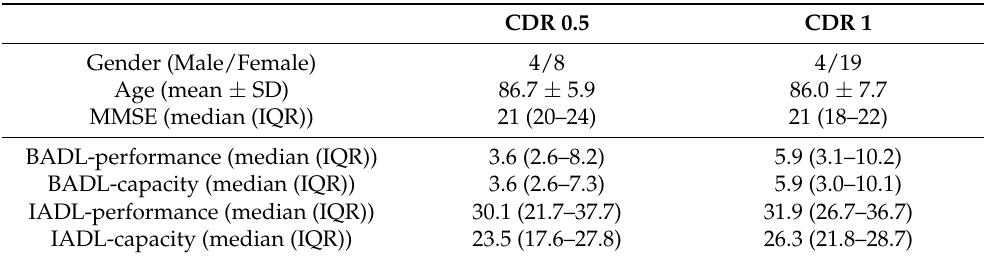
Table 1. Demographic of the subjects and differences in performance and capacity between CDR 0.5 and